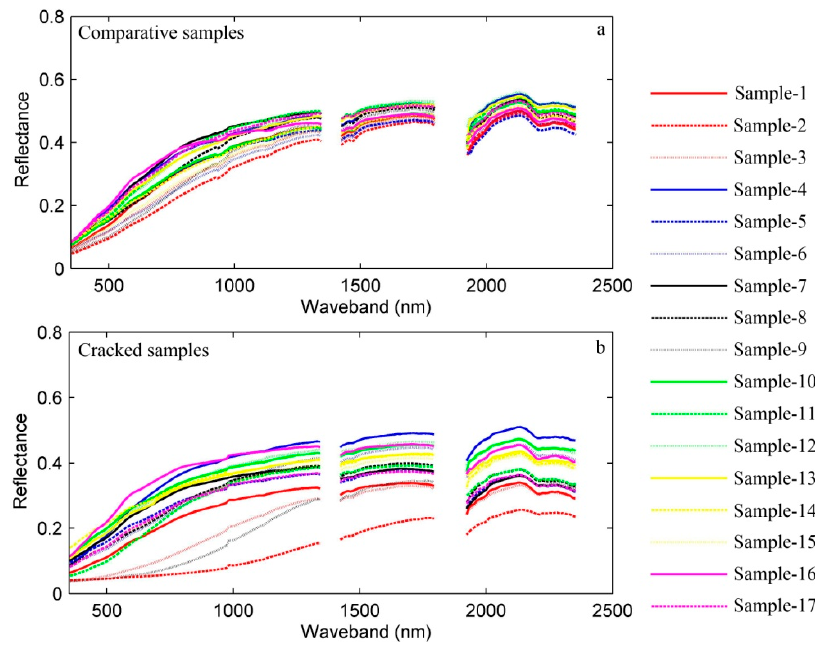
Figure 3. Spectral reflectance curves of soil samples with different salinity levels.